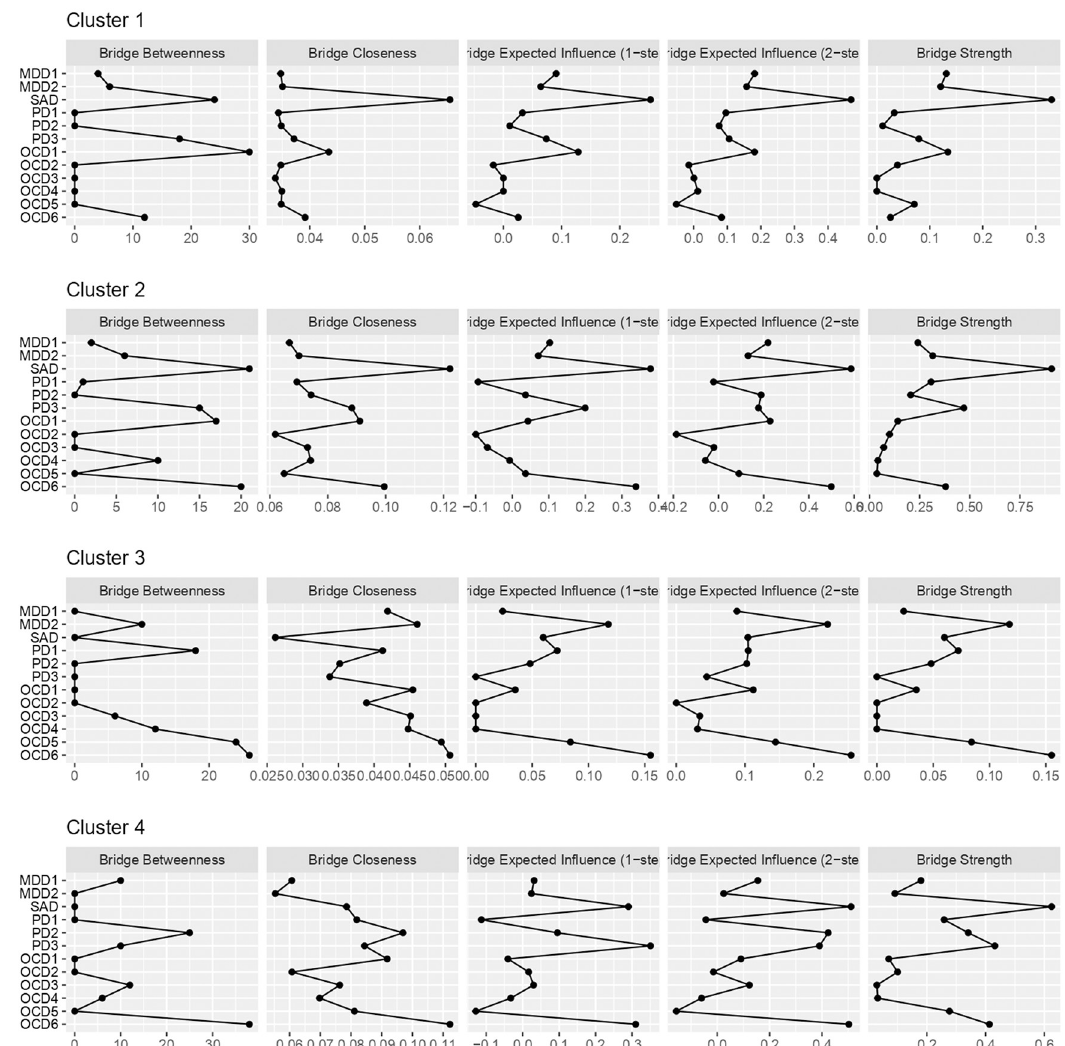
Fig 5. Bridge centrality indexes (standardized z -scores) calculated in each partial correlation network. MDD = major depressive disorder, PD = panic disorder, SAD = social anxiety disorder, OCD = obsessive-compulsive disorder. MDD1 = cognitive/affective symptoms, MDD2 = somatic symptoms, PD1 = physical concerns, PD2 = cognitive concerns, PD3 = social concerns, OCD1 = hoarding, OCD2 = checking, OCD3 = ordering, OCD4 = neutralizing, OCD5 = washing, OCD6 = obsessing.